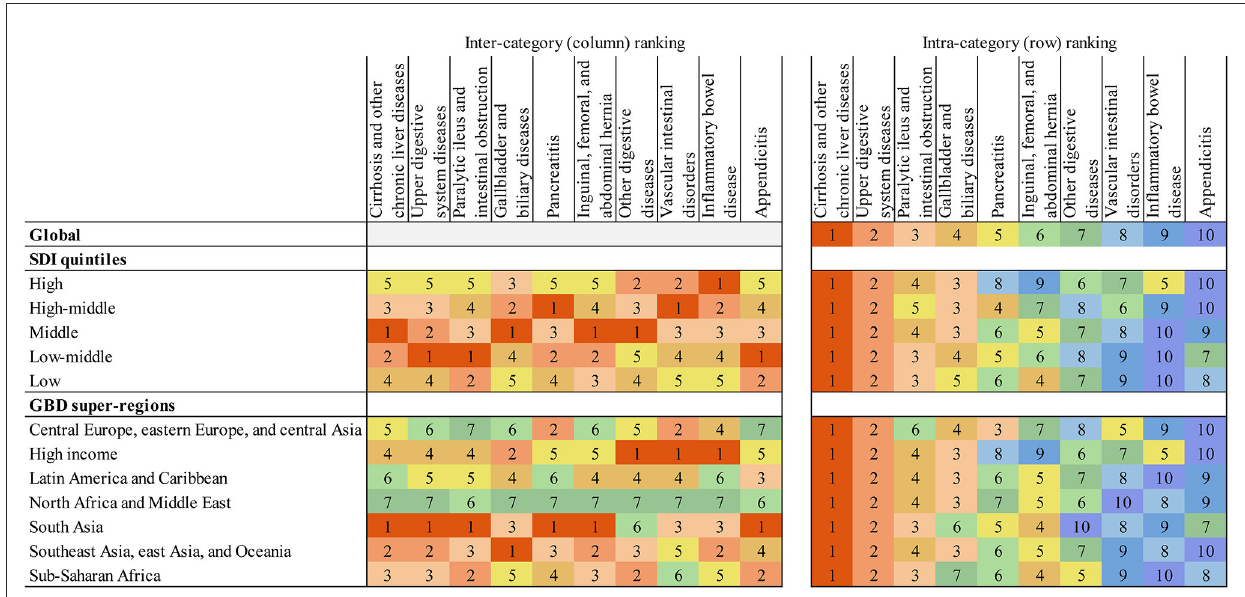
FIGURE4 Digestive diseases ranked by numbers of DALYs for both sexes combined, 2019. Intercategory ranking refers to ranking vertically (ranking between the SDI quintiles and GBD super-regions). Intracategory ranking refers to ranking horizontally (ranking within each SDI quintile and GBD super-region). Number ranking is assigned by total absolute DALYs, with 1 representing the highest rank and greatest absolute DALY burden. DALYs, disability-adjusted life-years; GBD, Global Burden of Disease, Injuries, and Risk Factors Study; SDI, Sociodemographic